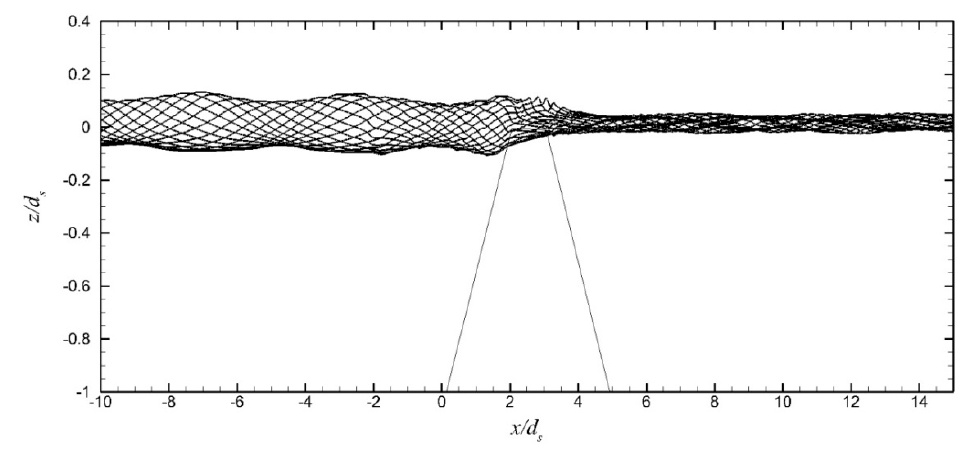
Figure 6. The envelope of the free surface elevation of waves breaking over the ZFB case 1.